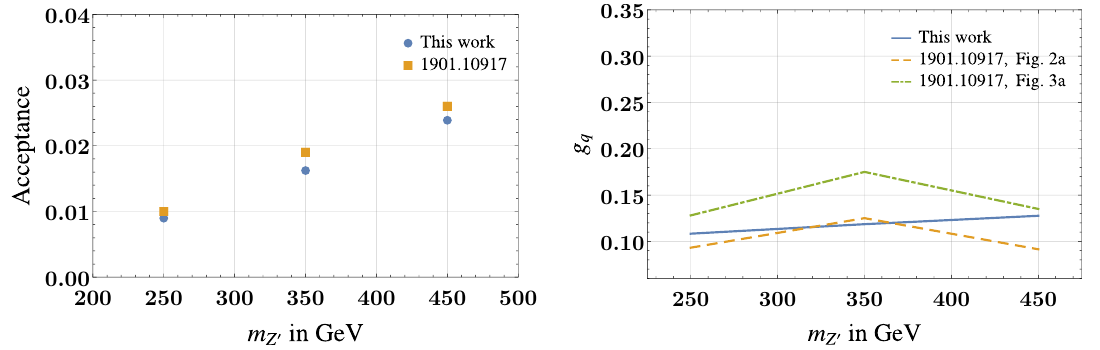
Figure 19 . Comparison of the acceptance (left) and of the limit on the coupling (right) between our analysis and the experimental analysis from ref. [62]